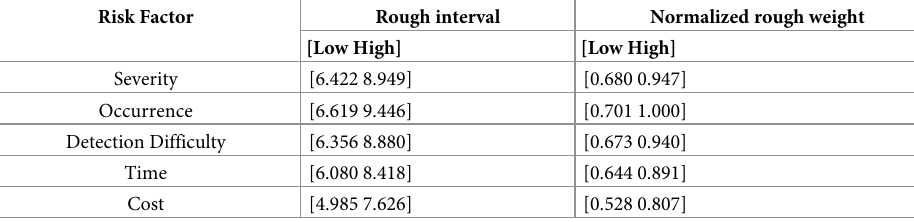
Table 3. The rough interval and normalized weights for S, O, D, T, and